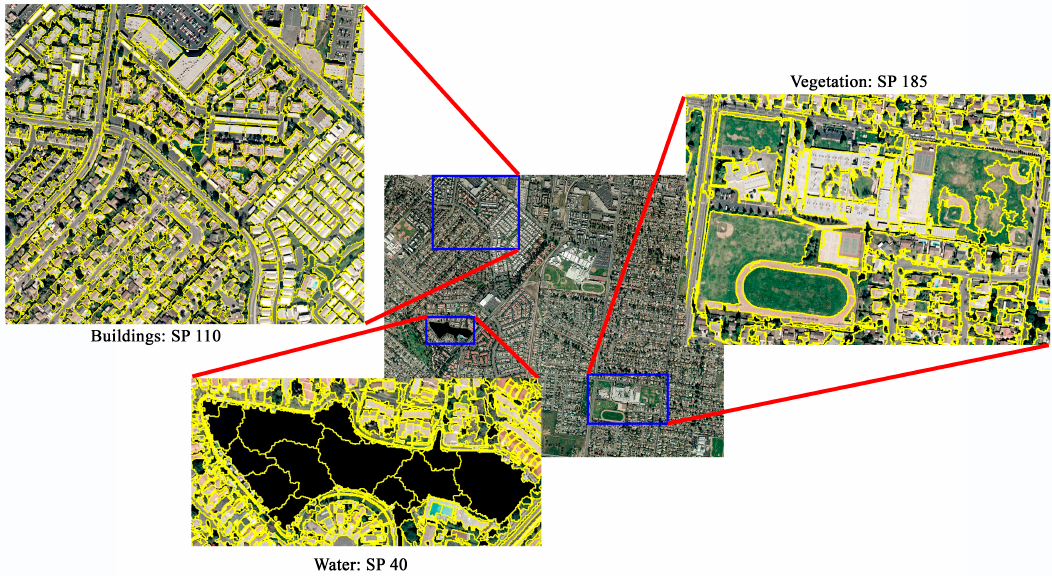
Figure A2. Segmentation results of the building, vegetation, and water classes in the 65-cm test image.